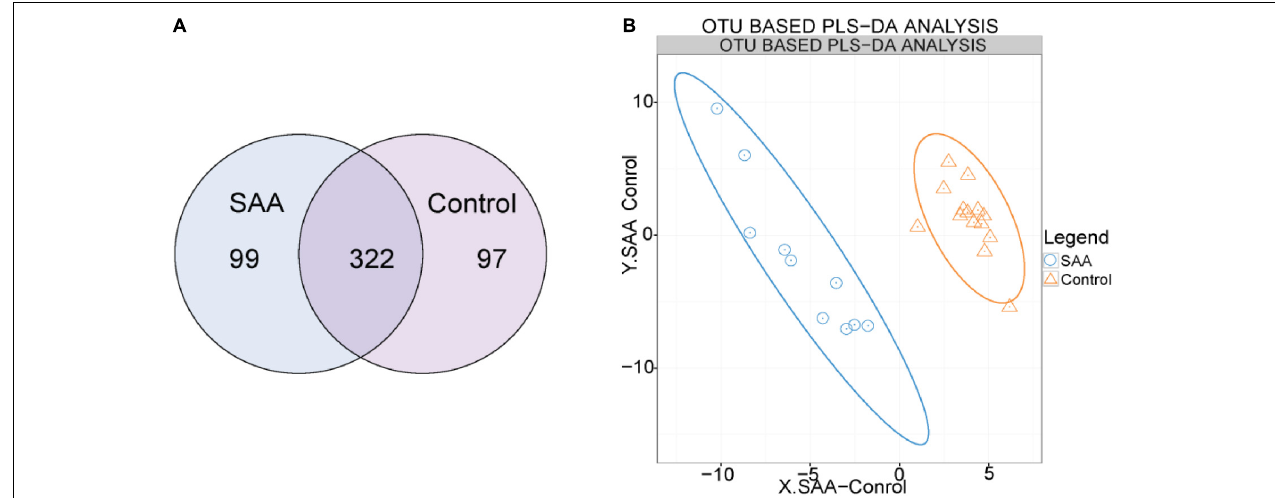
FIGURE 1 | (A) Venn diagram of the OTUs (A: SAA group, N: control group). (B) Out-based PLS-DA analysis. Orange triangles represent intestinal microbial samples from the control group, and blue circles represent samples from patients with SAA.